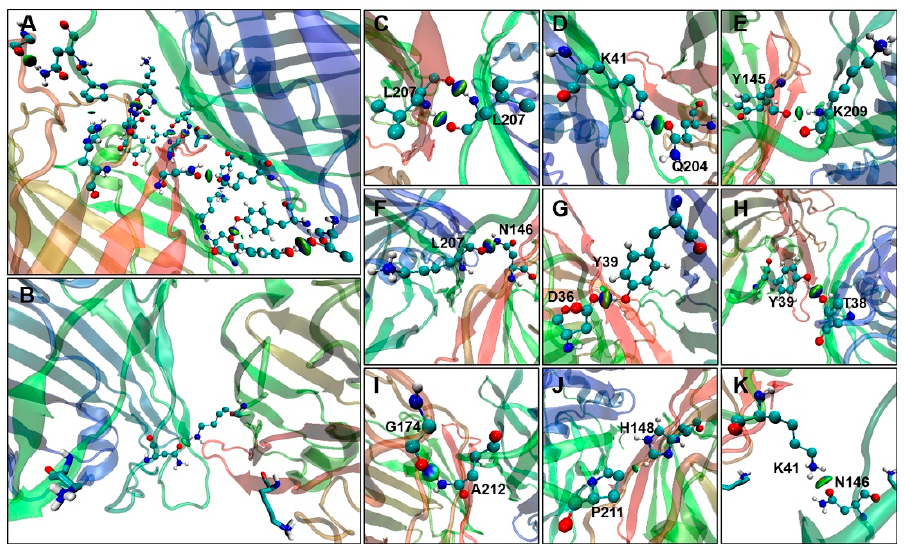
Figure 5. The 3D isocontours generated using an independent gradient model (IGM) represent the non-covalent interactions (NCIs) formed between GFP molecules. Green areas correspond to λ 2 ≈ 0 (weak). λ 2 is one of the three eigenvalues of the electron-density Hessian matrix, with λ 1 ≤ λ 2 ≤ λ 3. All isosurfaces are colored according to a blue-green-red scheme over a range of − 0.1 < sign ( λ 2) ρ < 0.1 a.u. ( A ) The interface region and isosurface map between two GFP monomers. ( B ) The interface region and isosurface map between two GFP-A206K monomers. ( C – J ) The key non-covalent interaction and isosurface map of residues near A206 at the GFP-dimer interface. ( K ) The non-covalent interaction and isosurface map between K41 and N146 of GFP-A206K.